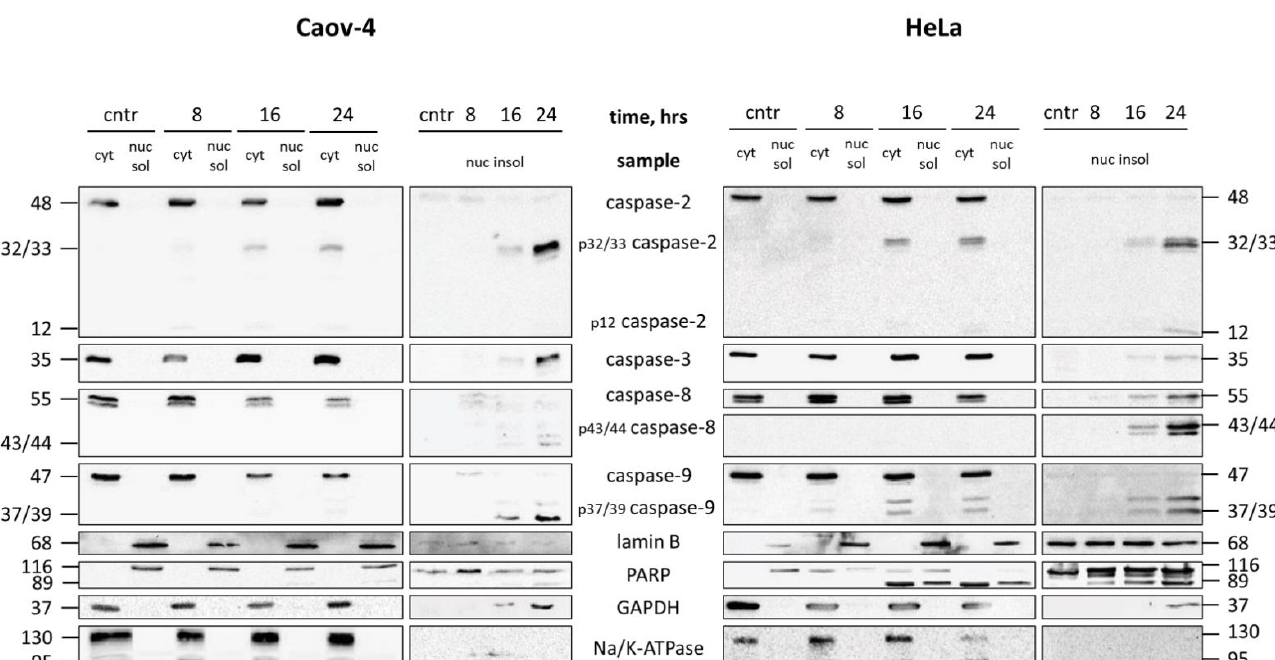
Figure 4. Analysis of RIPA-soluble and RIPA-insoluble portions of the nuclear fraction. WB analysis of cytoplasmic (cyt), RIPA-soluble (nuc sol), and RIPA-insoluble (nuc insol) fractions obtained from Caov-4 and HeLa cells treated with 35 µM cisplatin for the indicated time periods (hrs—hours). Cntr, control (untreated) cells. The purity of the resulting fractions was assessed by staining for markers of the cell membrane (Na/K ATPase), cytoplasm (GAPDH), nuclear envelope (Lamin B). p12 and p32, p37/39, p43/44, for cleaved forms of caspase-2, -9, and -8, respectively, with the corresponding molecular weight.